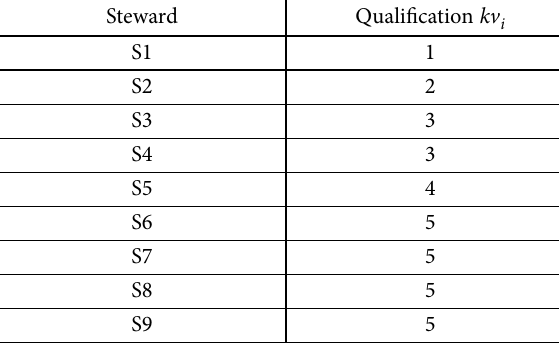
Table 4. Stewards’ qualification level (category)